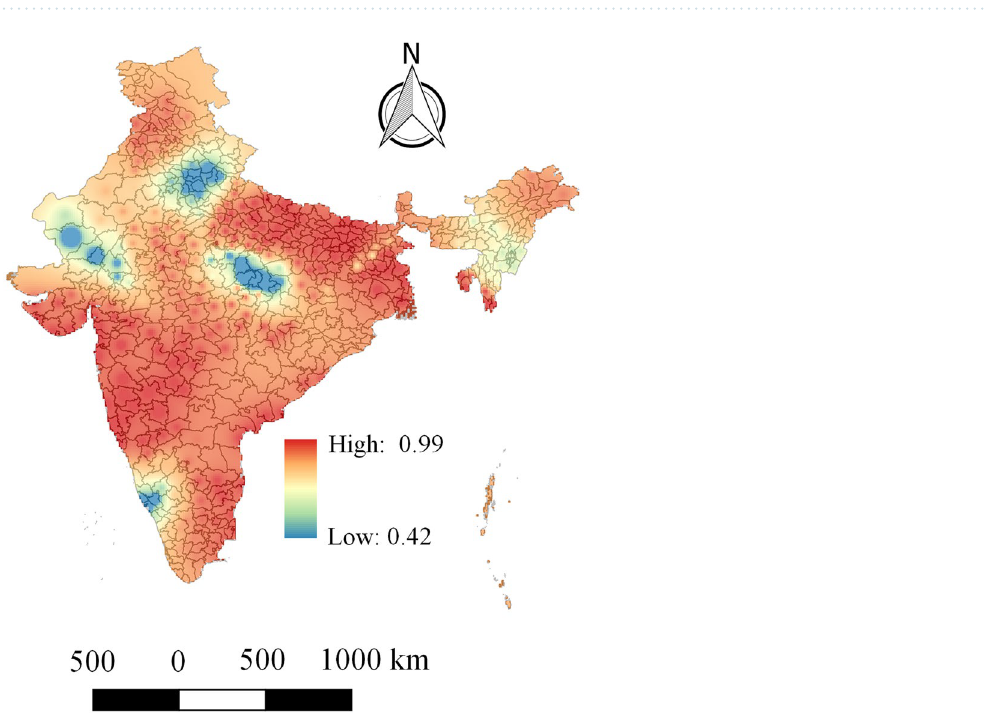
Figure 3. Scatter plot of the observed and the predicted COVID-19 death count using ( a ) global OLS model and ( b ) GWR model.